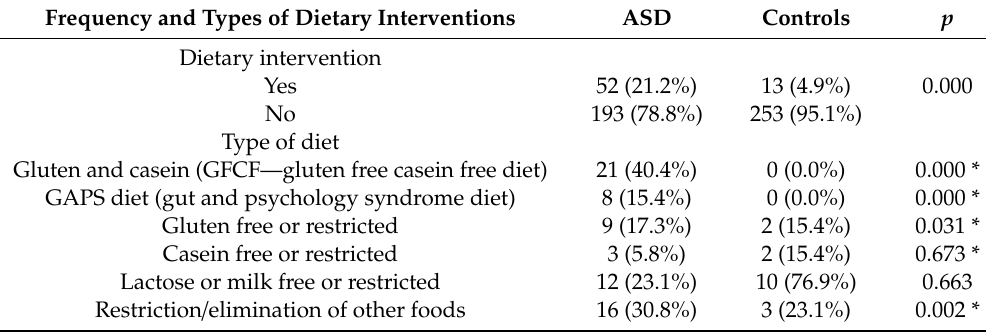
Table 5. Frequency and types of dietary interventions in children and adolescents with autism spectrum disorders (ASD) and controls ( n , % of total